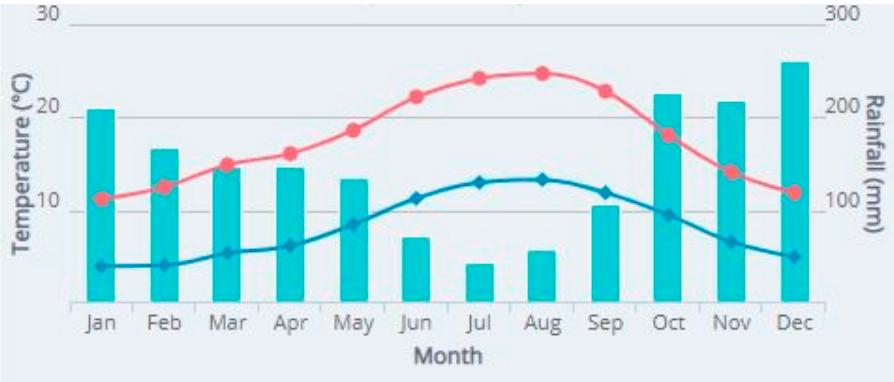
Figure 3. Climatological information based on monthly averages for the 30-year period 1971–2000 of the Territorial Context 2 [38]. Table 2. Description of Territorial Context 2.